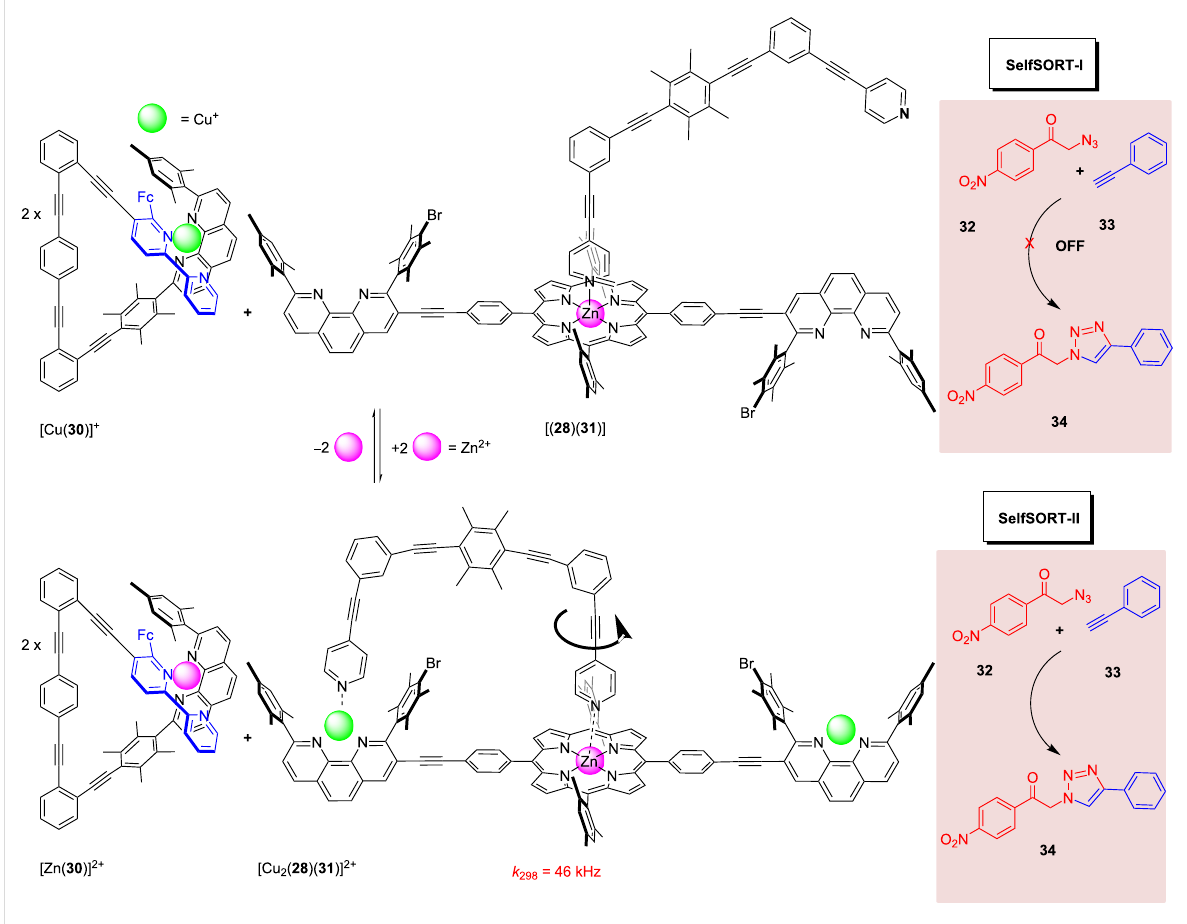
Figure 12: Double self-sorting leads to a catalytic machinery in SelfSORT-II, in which the 46 kHz-nanorotor acts as copper(I)-based catalyst in a click